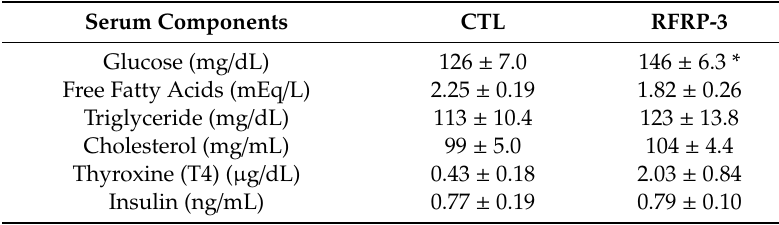
Table 1. Blood chemistry during chronic intracerebroventricular (i.c.v.) infusion of RFamide-related peptide-3